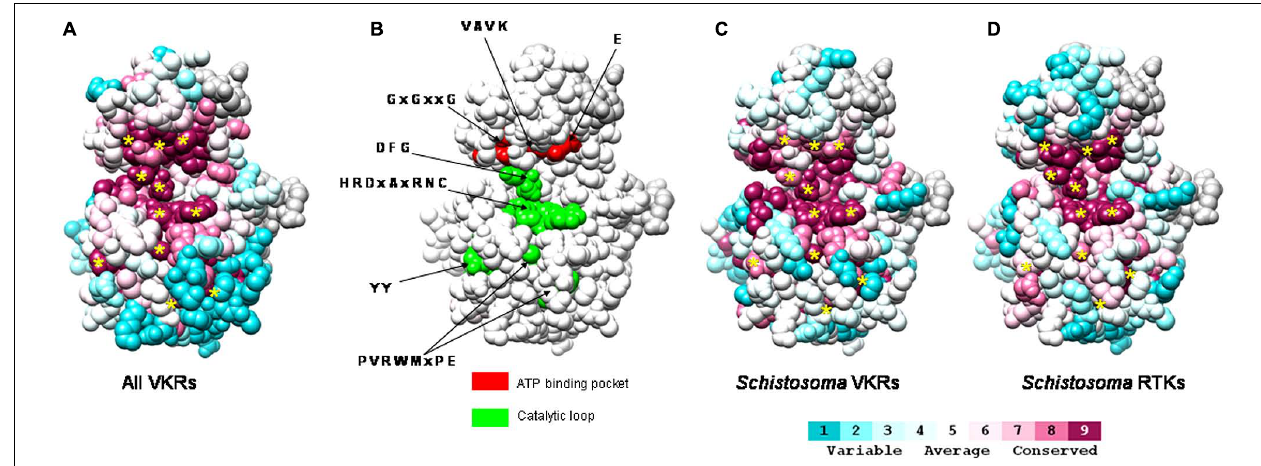
FIGURE 2 | Conservation of schistosome RTK tyrosine kinase catalytic sites. An evolutionary trace analysis of the conservation of residues in TK domains was performed using sequence alignment of (A) 40 VKRs already known in various invertebrate species (Vanderstraete etal., 2013a), (C) four VKRs of Schistosoma (SmVKR1 AAL67949.1 and SmVKR2 ADD91576.1, and two VKRs of Schistosoma haematobium Sha_103537 and Sha_104501), (D) various Schistosoma RTKs (EGF, insulin and VKR receptors) including SmVKR1, SmVKR2, the two ShVKRs, SmIR1 (AAN39120), SmIR2 (AAV65745.2), SjIR1 (ACT20714.1), SjIR2 (ACT20715.1), and SER (AAA29866.1). Visualization of the conservation was performed on the human IR TK crystal structure (PDB accession number 1IRK; Ahier etal., 2009). The alignment generated with ClustalW